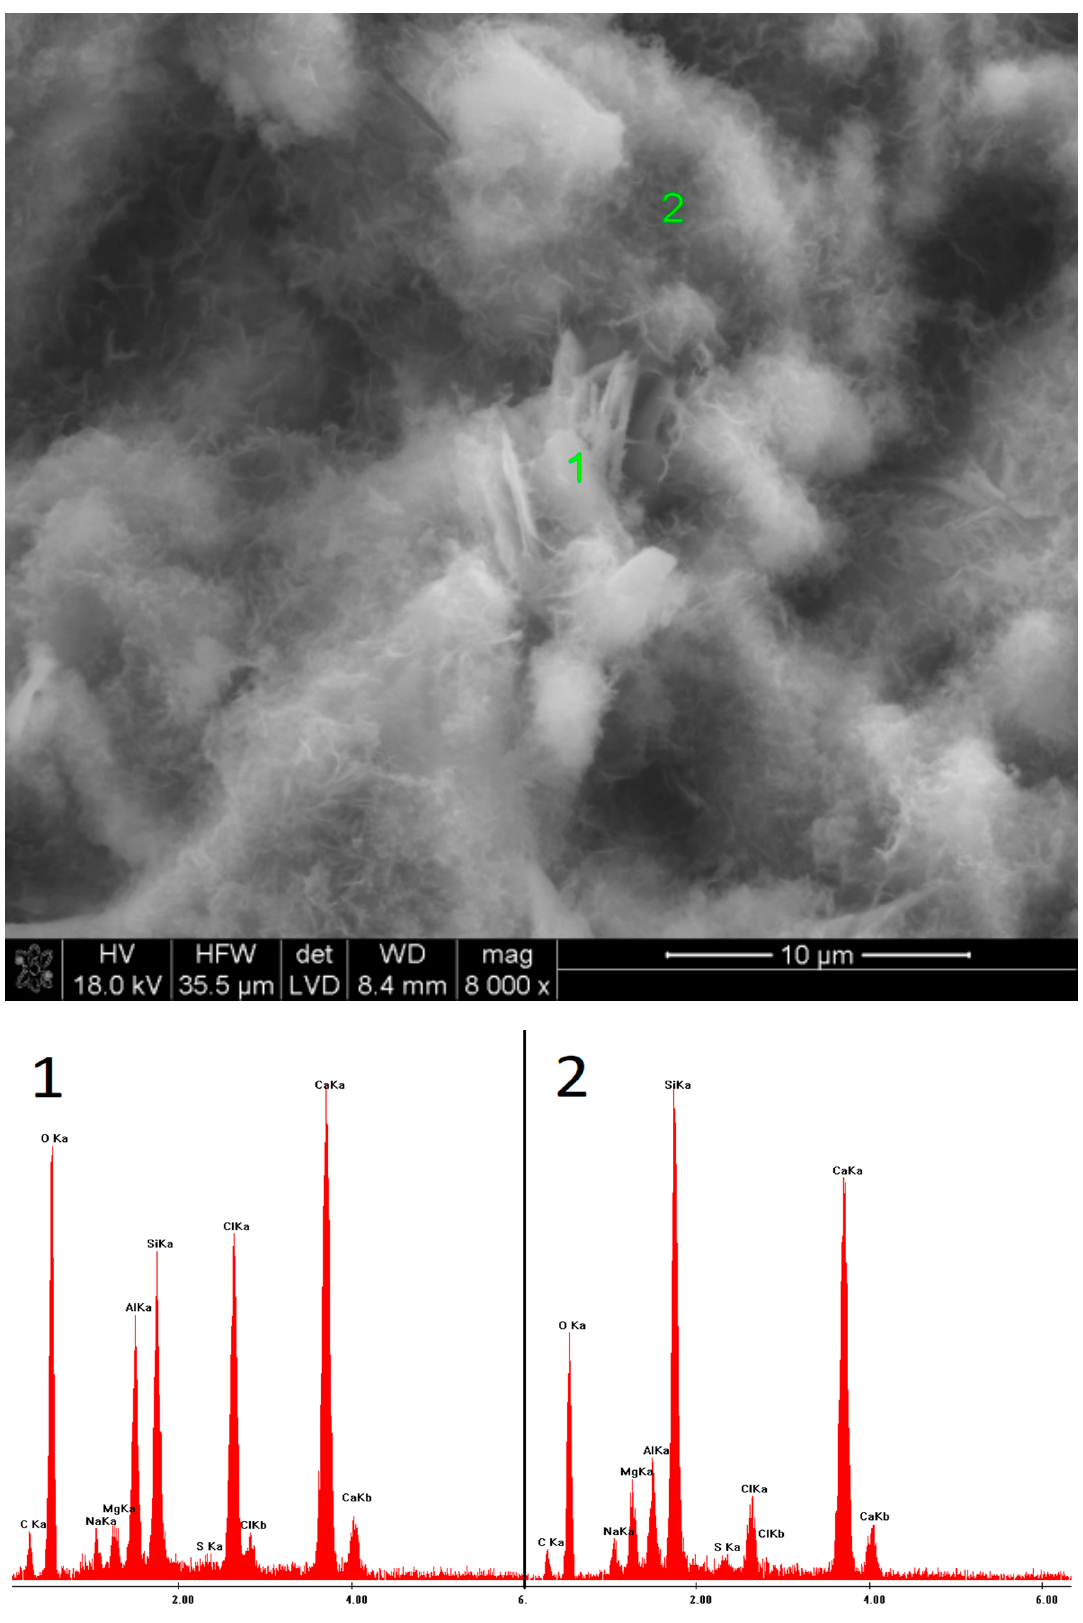
Figure 20. Microstructure of slag paste activated with sodium chloride after 360 days of curing— SEM + EDS; 1 , 2 —hydration products.